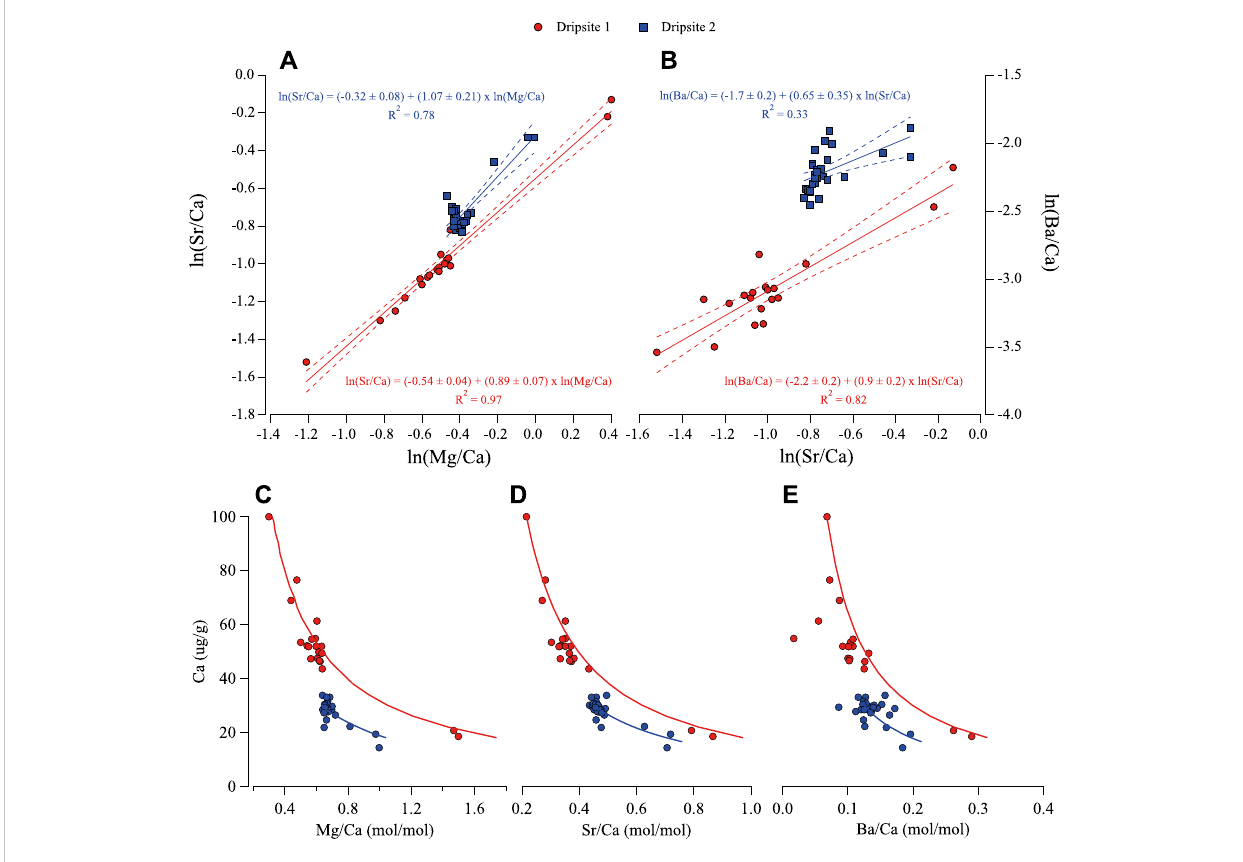
FIGURE 6 Tests for ICD/PCP using (A) Mg/Ca vs. Sr/Ca following Sinclair (2011) and (B) Sr/Ca vs. Ba/Ca following Bernal et al. (2016). Dashed lines correspond totheslopeuncertainty. (C) mass-balancecalculationstestingforPCPmodulationofMg/Ca variabilityindripwater. (D) ,sameas (C) but forSr/Caand (E)